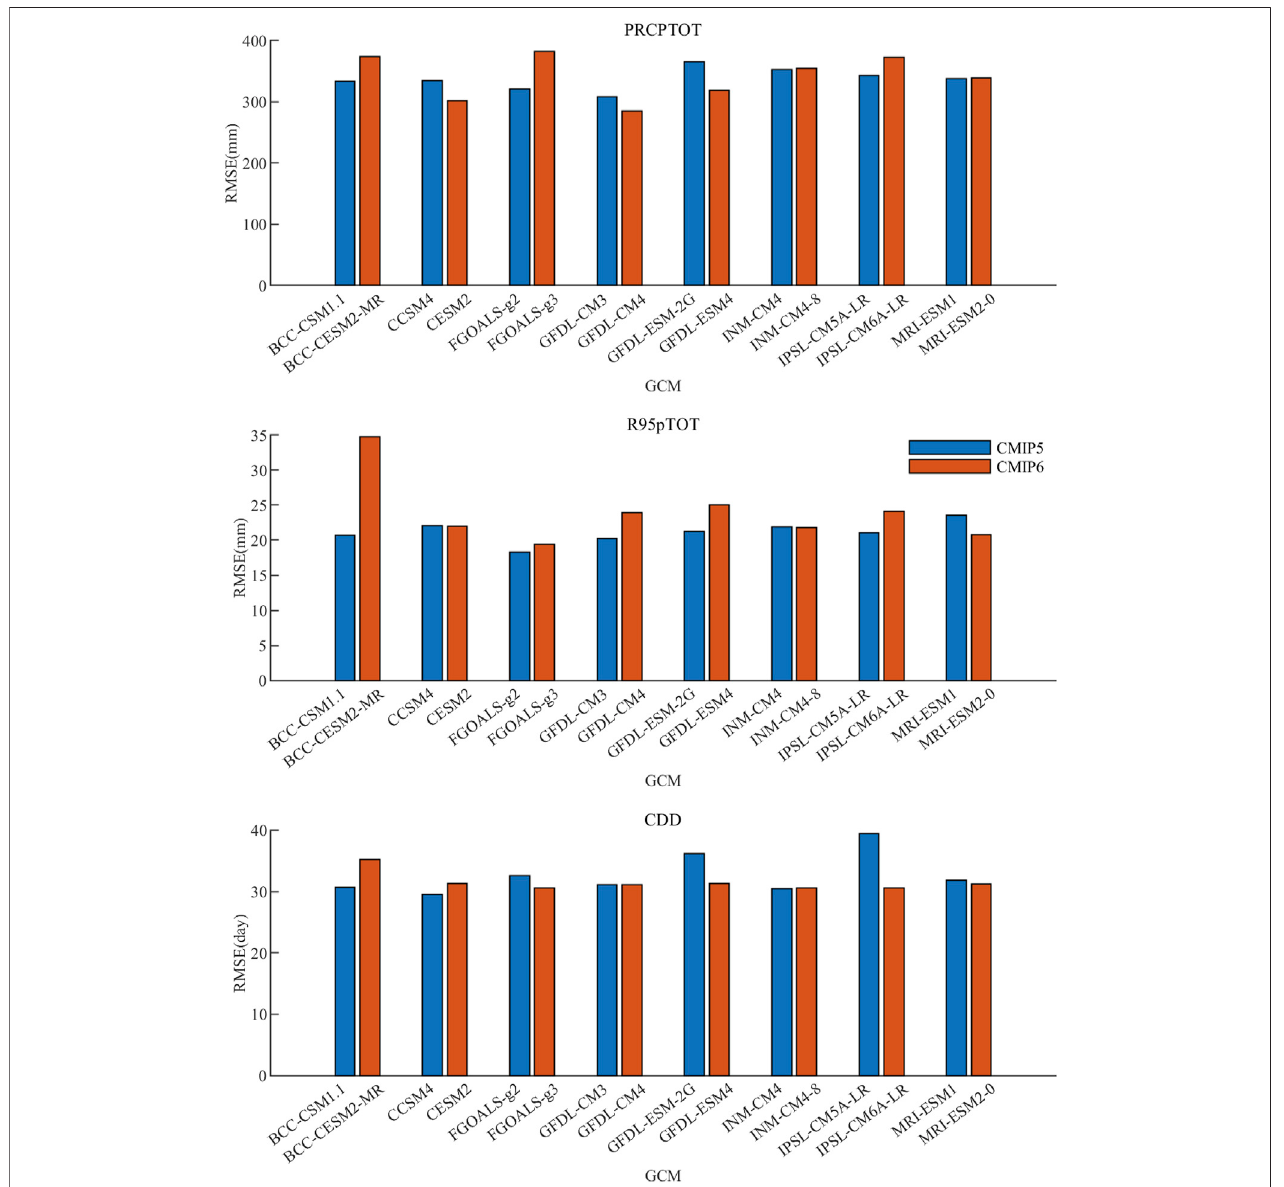
FIGURE3| Theland-averageRMSEofthePCRPTOT,R95pTOT,CDDinthehistoricalperiod(1982 – 2005)ofeachGeneralCirculationModel(GCM)inCMIP5and CMIP6.